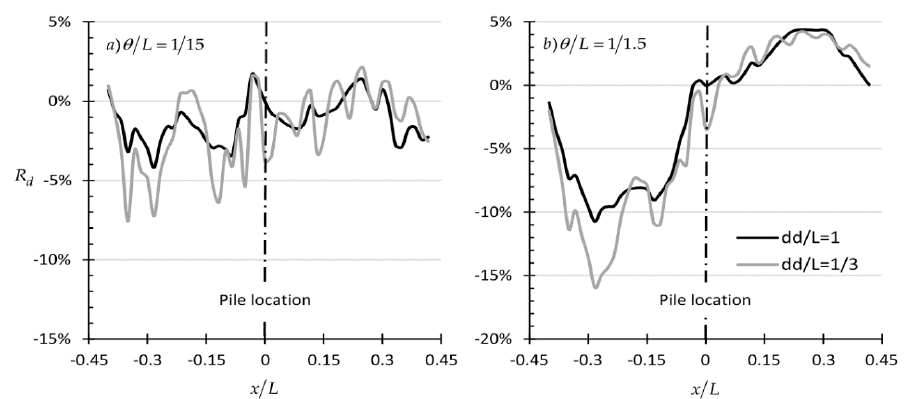
Figure 11. Relative di ff erence R d ( = Λ / Λ ref-1; recall Equation (3)) versus x / L (relative distance from the Figure 11 . Relative difference R d (=Λ/Λref-1; recall Equation 3) versus x/L (relative distance from the pile location) for ( a )   1/15 L and ( b )   1/1.5 L . Charts drawn using mean friction angle pile location) for ( a ) θ / L = 1/15 and ( b ) θ / L = 1/1.5. Charts drawn using mean friction angle values. values.